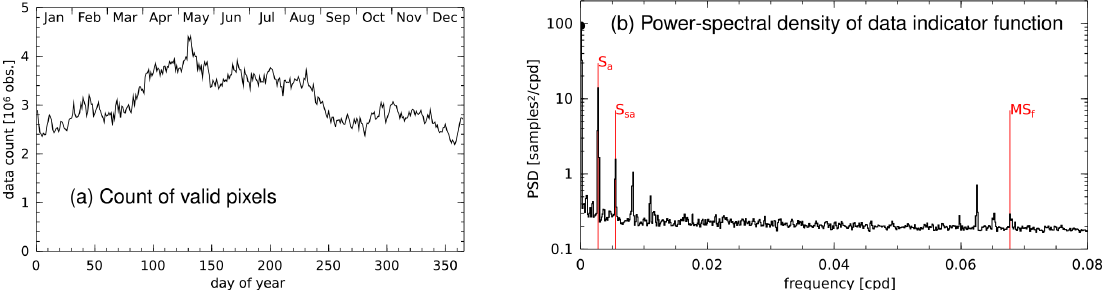
Figure A1. (a) The count of good data, i.e., cloud-free pixels, exhibits a notable annual cycle associated with monsoon variability. Data counts are about 30% greater during the dry season than during the monsoon season (roughly September through March). (b) The power spectral density of the data indicator function, w , contains significant peaks at the frequency of the annual cycle ( S a ) and its harmonics (the semi-annual cycle, S sa , is indicated). A peak at the fortnightly frequency (MS f ) is present, but it is almost 3 orders of magnitude smaller than the peak at the zero frequency (98 samples 2 cpd − 1 (cpd – cycles per day), marked with a dot). The spectrum is computed by averaging the Hamming-windowed periodograms computed from data indicator time series at each ocean pixel.